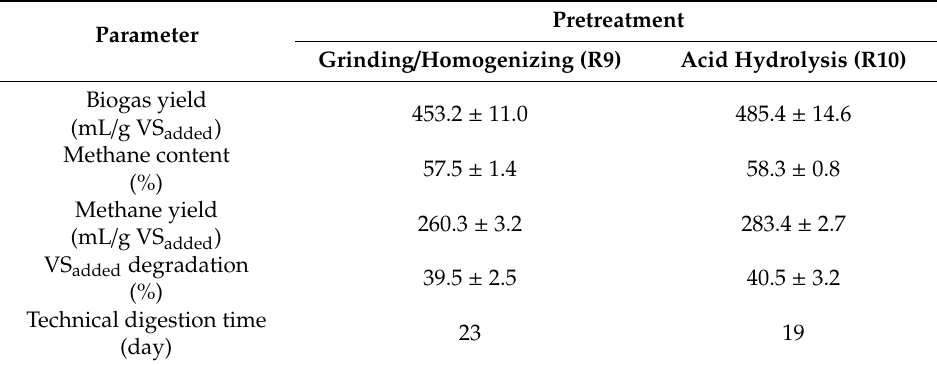
Table 5. Results from the combined treatment of pretreated PPW and